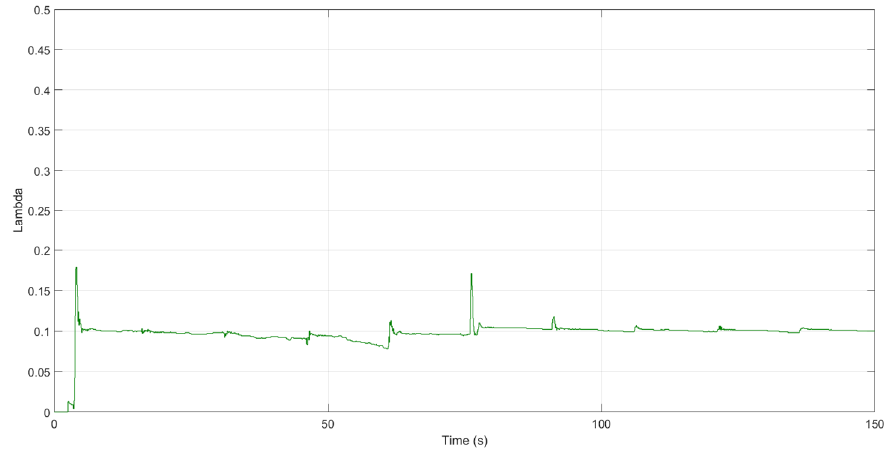
Figure 11. Rate ‐ of ‐ change of applied controls (process input) in the constrained case.